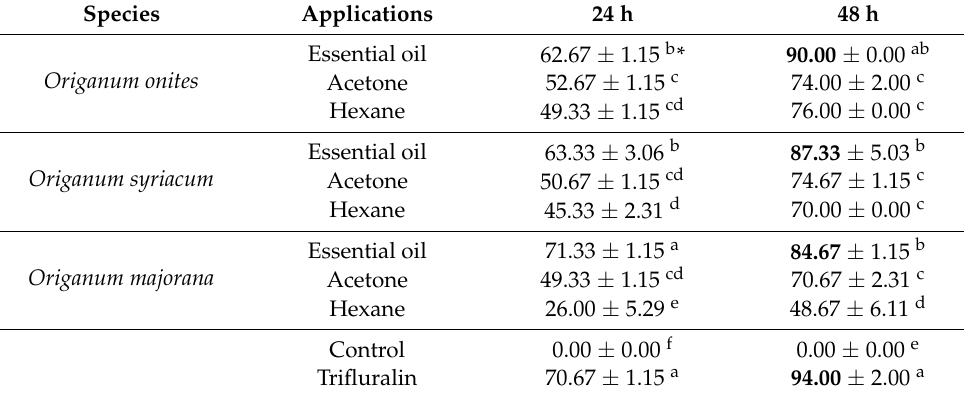
Table 4. The mortality rate (%) of Lactuca serriola in